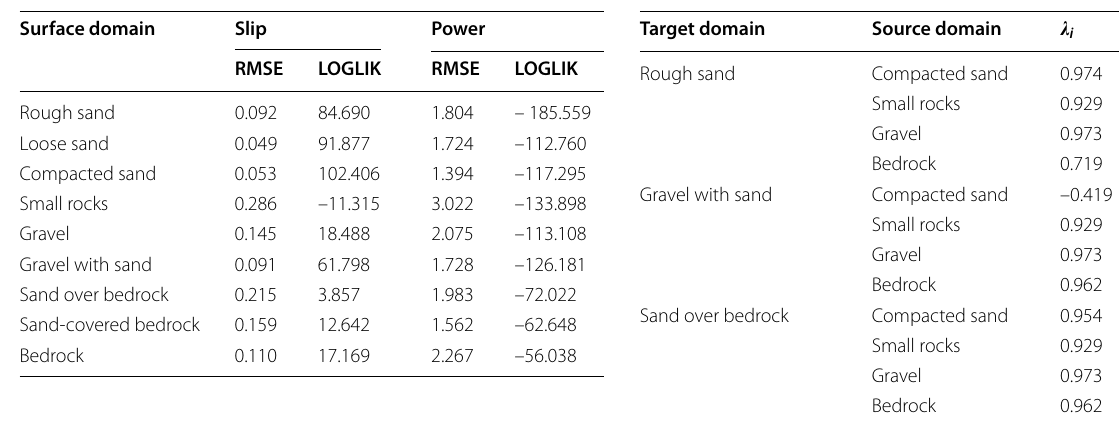
Table 4 Domain similarity (cid:31) i and weight w i learned for